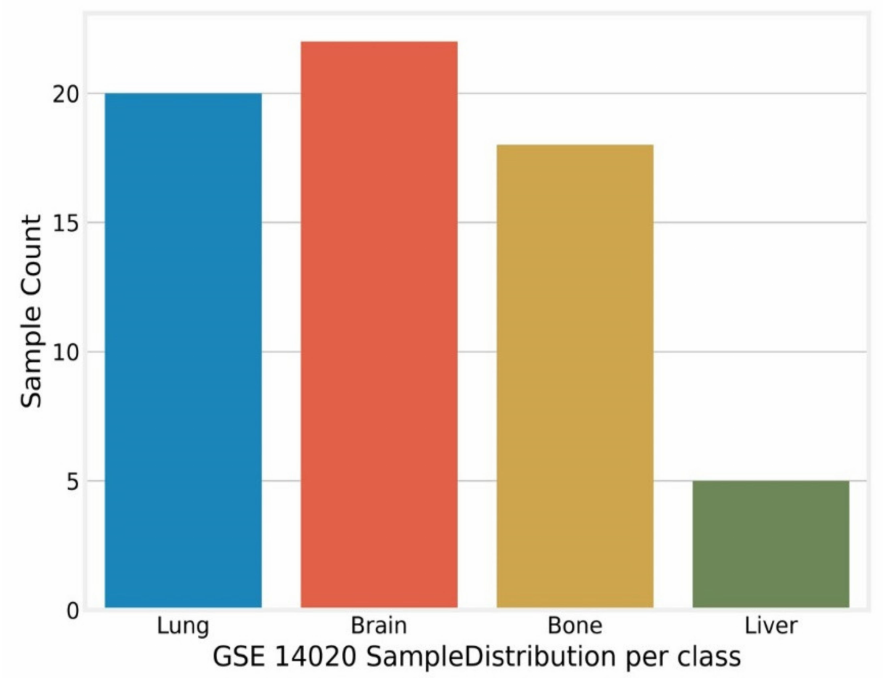
Figure 6. GSE14020 Class